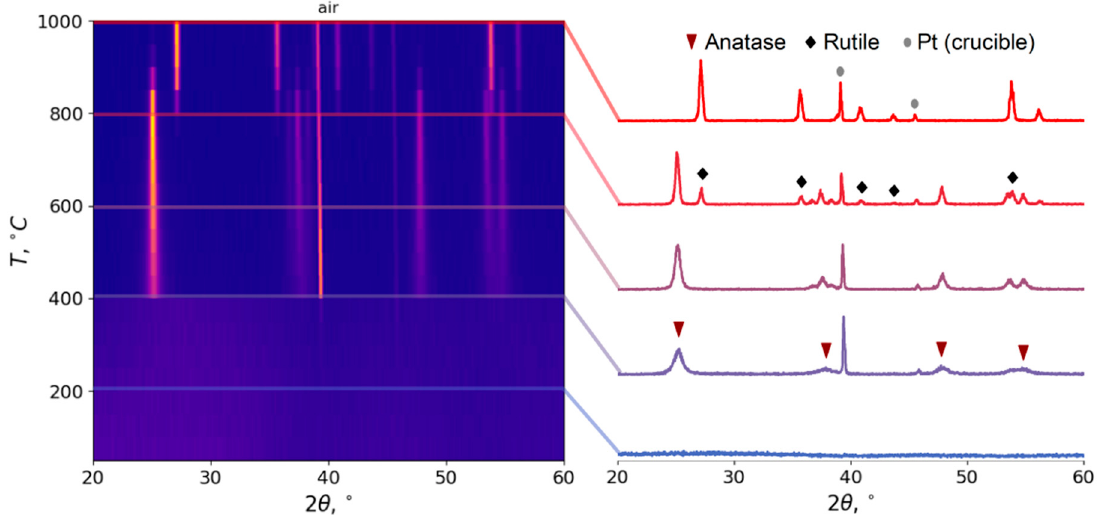
Figure 5. High-temperature X-ray diffraction (XRD) patterns of the spherical particles annealed in air; heating rate 5°/min.